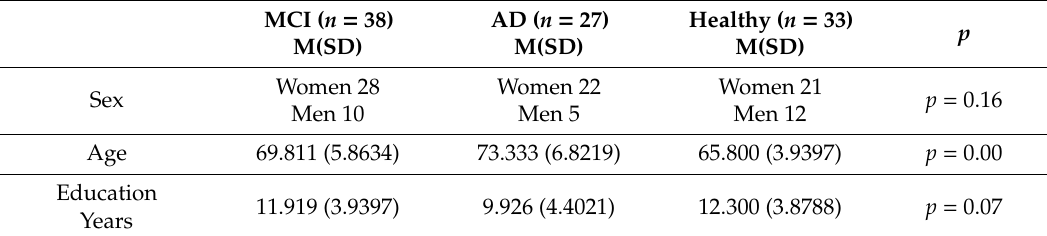
Table 2. Demographic characteristics of Thessaloniki pilot’s participants.